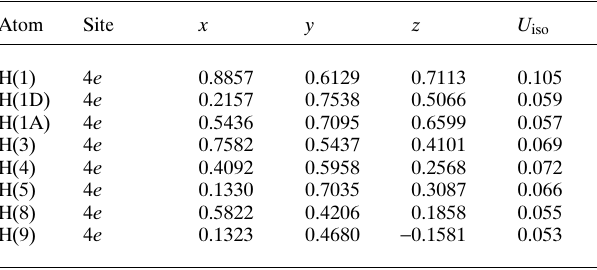
Table 2. Atomic coordinates and displacement parameters (in Å 2 )